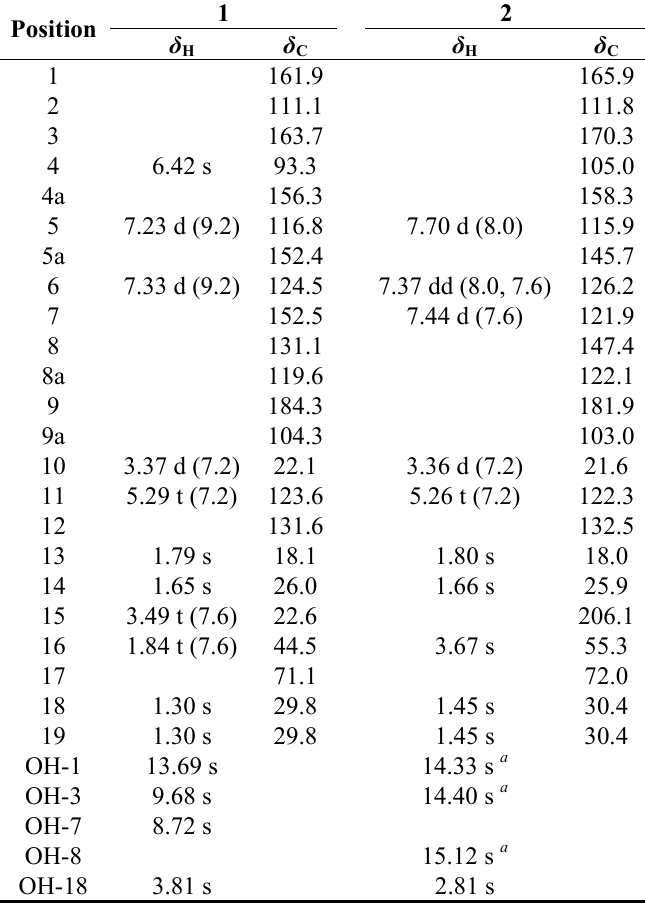
Table 1. 1 H- and 13 C- NMR Data of compounds 1 and 2 at 400 and 100 MHz, resp., in . δ in ppm, J in Hz. acetone- d 6